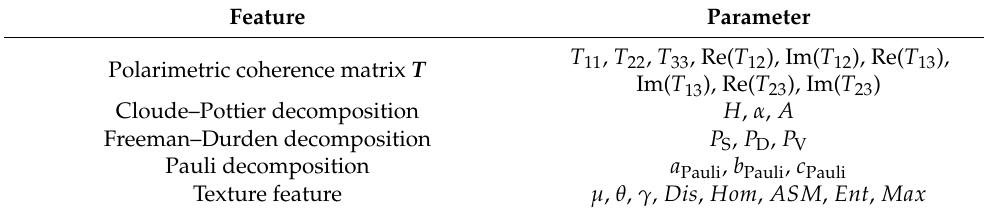
Table 1. Features of PolSAR